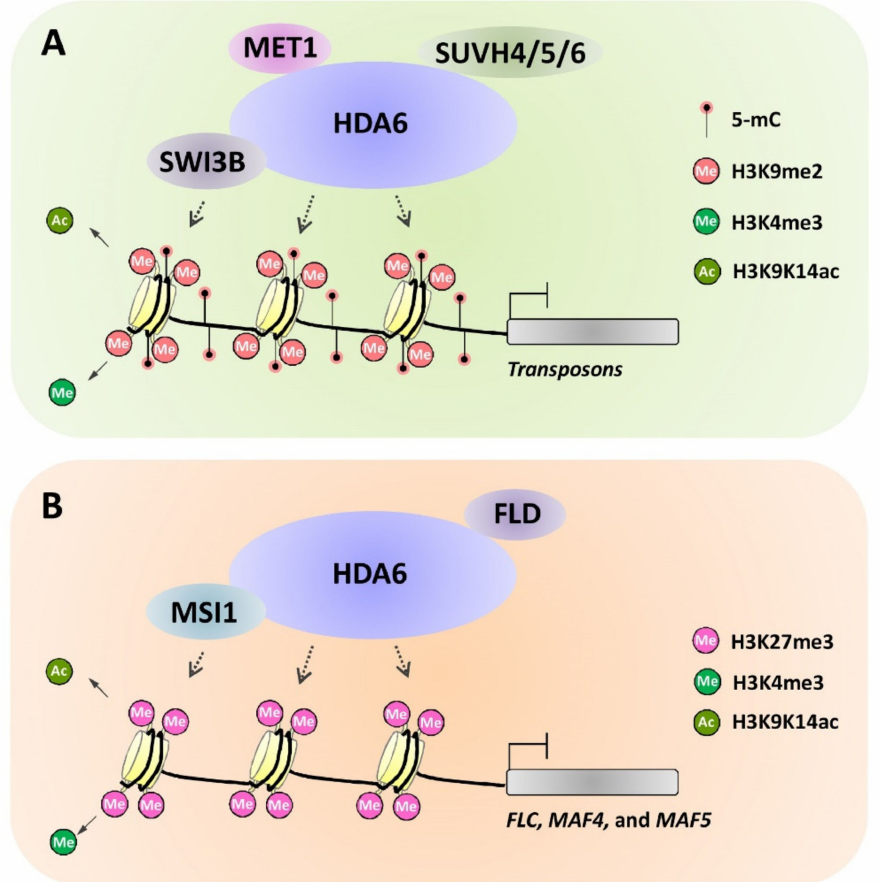
Figure 2. Simplified models for the epigenetic interplays mediated by HDA6 complex. ( A ) HDA6 interacts with MET1, SUVH4/5/6, and SWI3B, to maintain the transposon silencing by decreasing histone H3 acetylation and nuclear occupancy, as well as increasing DNA methylation and histone H3K9me2 in A. thaliana . ( B ) Histone deacetylase HDA6 associates with histone demethylase FLD and polycomb repressive complex 2 (PRC2) subunit AtMSI1 to repress the expression of FLC , MAF4 , and MAF5 via decreasing H3K9Ac and promoting H3K27Me3, thereby fine-tuning the Arabidopsis flowering